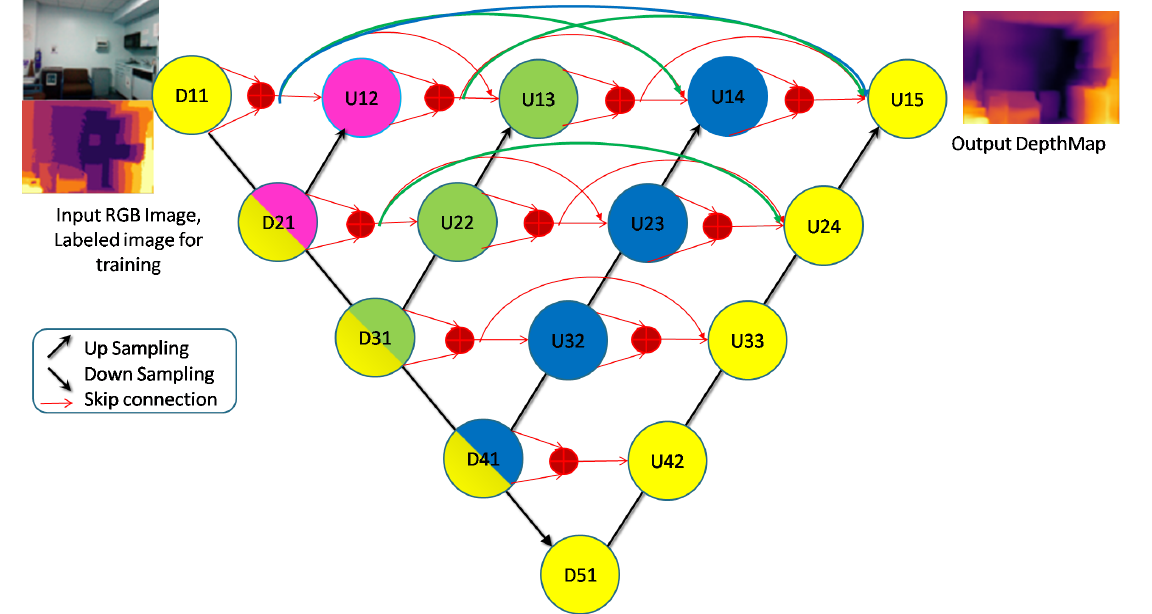
Figure 2. Our network architecture